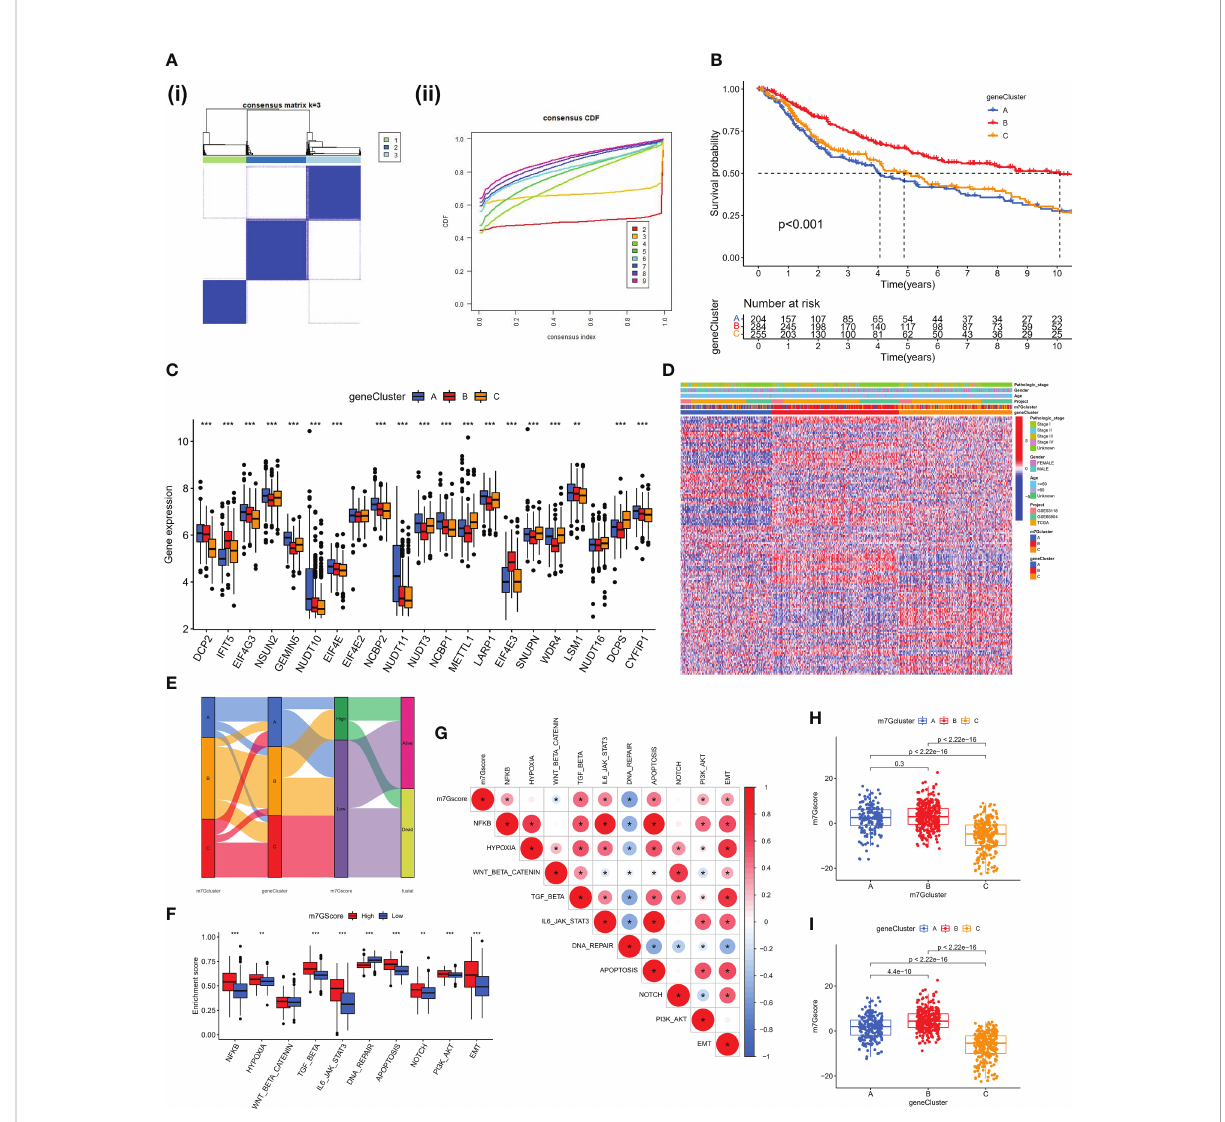
FIGURE 4 Construction of gene clusters and m7G score based on the DEGs. (A) DEGs were divided into 3 groups using Consensus clustering matrix. (B) K-M survival analysis of OS for different m7G gene clusters in meta-SKCM cohort(p < 0.001). (C) Histogram showing expression of m7G related genes in different gene clusters. The lines in the boxes mean median value. (D) Unsupervised clustering of gene expression of 21 m7G genes in the meta-SKCM cohort. Gene cluster, pathologic stage, gender, and age were used as annotations. (E) Alluvial diagram showing an association between m7G cluster,m7G gene cluster, m7G score, and survival status. (F) GSVA enrichment analysis based on Hallmark gene set according to high and low m7G scores. (**p < 0.01; ***p < 0.001). (G) Spearman analysis displaying the correlations between m7G score and hallmark gene set. Red represents positive correlation, blue represents negative correlation. (H, I) The difference of m7G score in distinct m7G clusters (above) and gene clusters (below). *represents p <